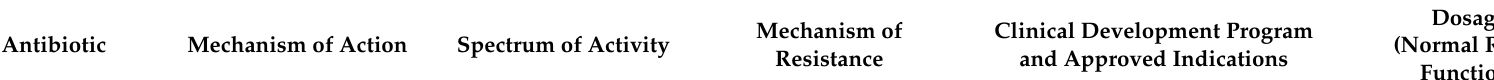
Table 1. Current and potential therapeutic options for DTR and PDR Gram-negative